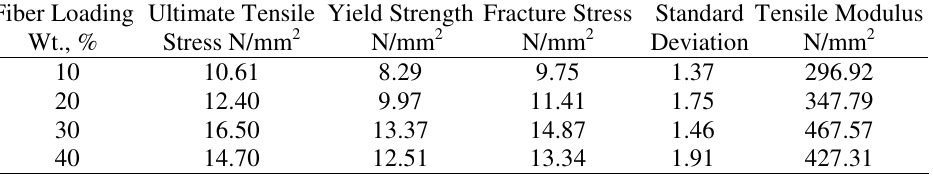
Table 1. Parameters obtained from tensile stress-strain curve at different loadings.